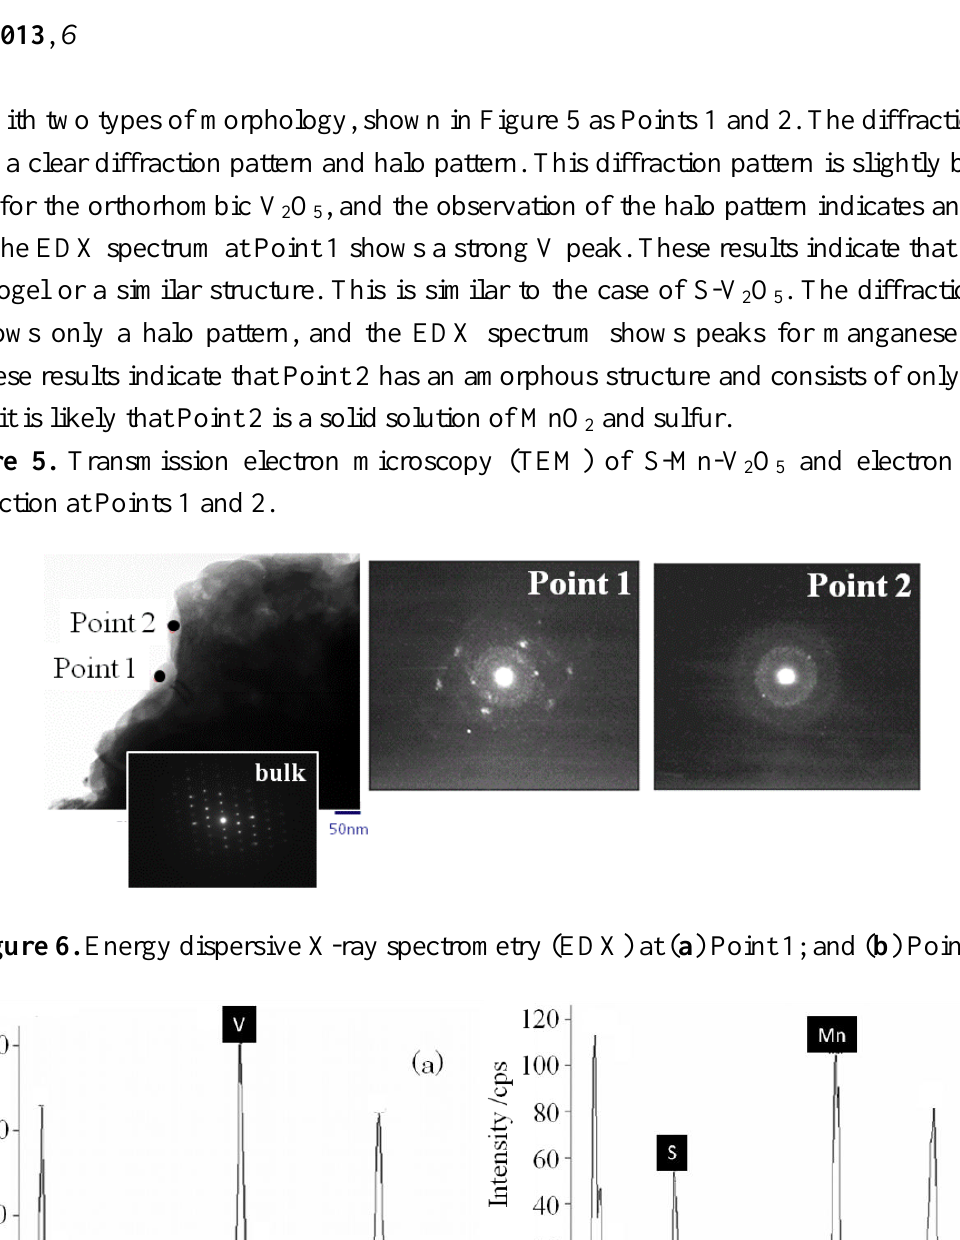
O and electron beam 2 5